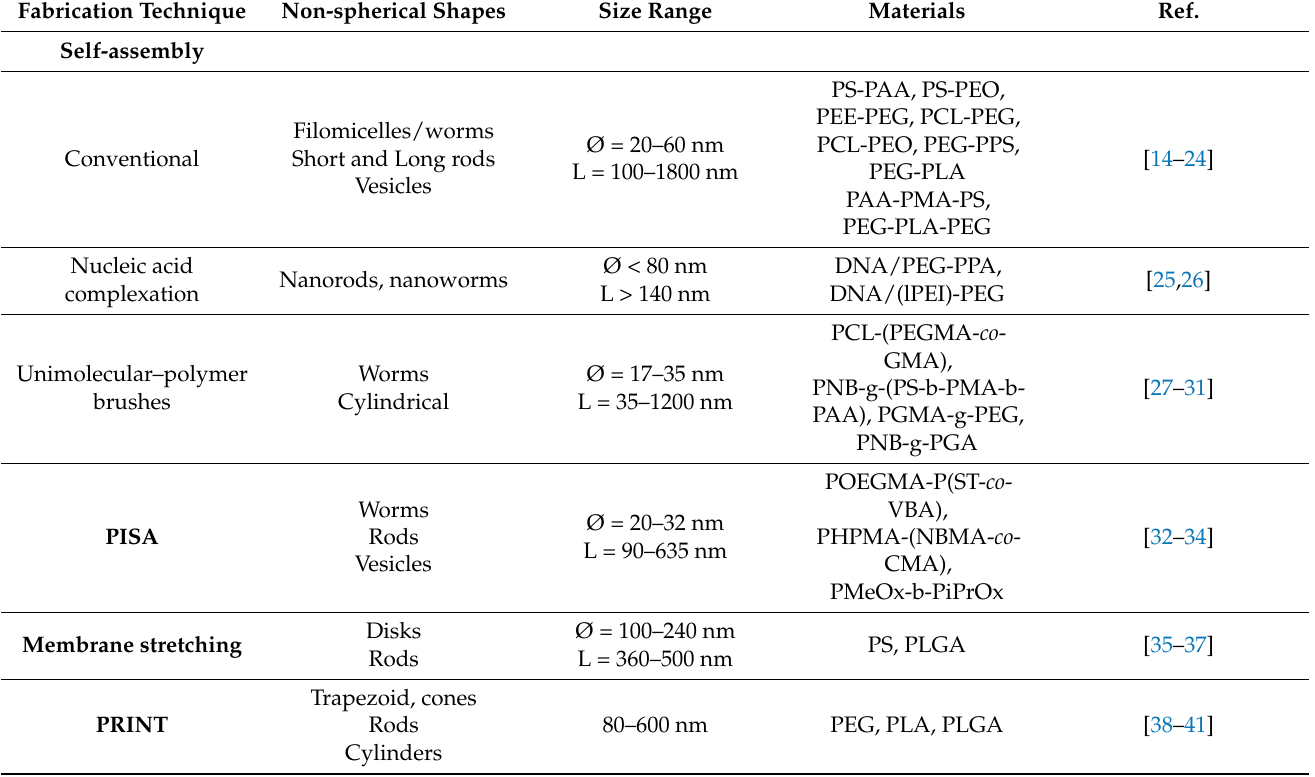
Figure 1. Most common non-spherical polymeric nanoparticles used in drug delivery. Table 1. Manufacturing methods for non-spherical nanoparticles of different shape, size and mate- rial.